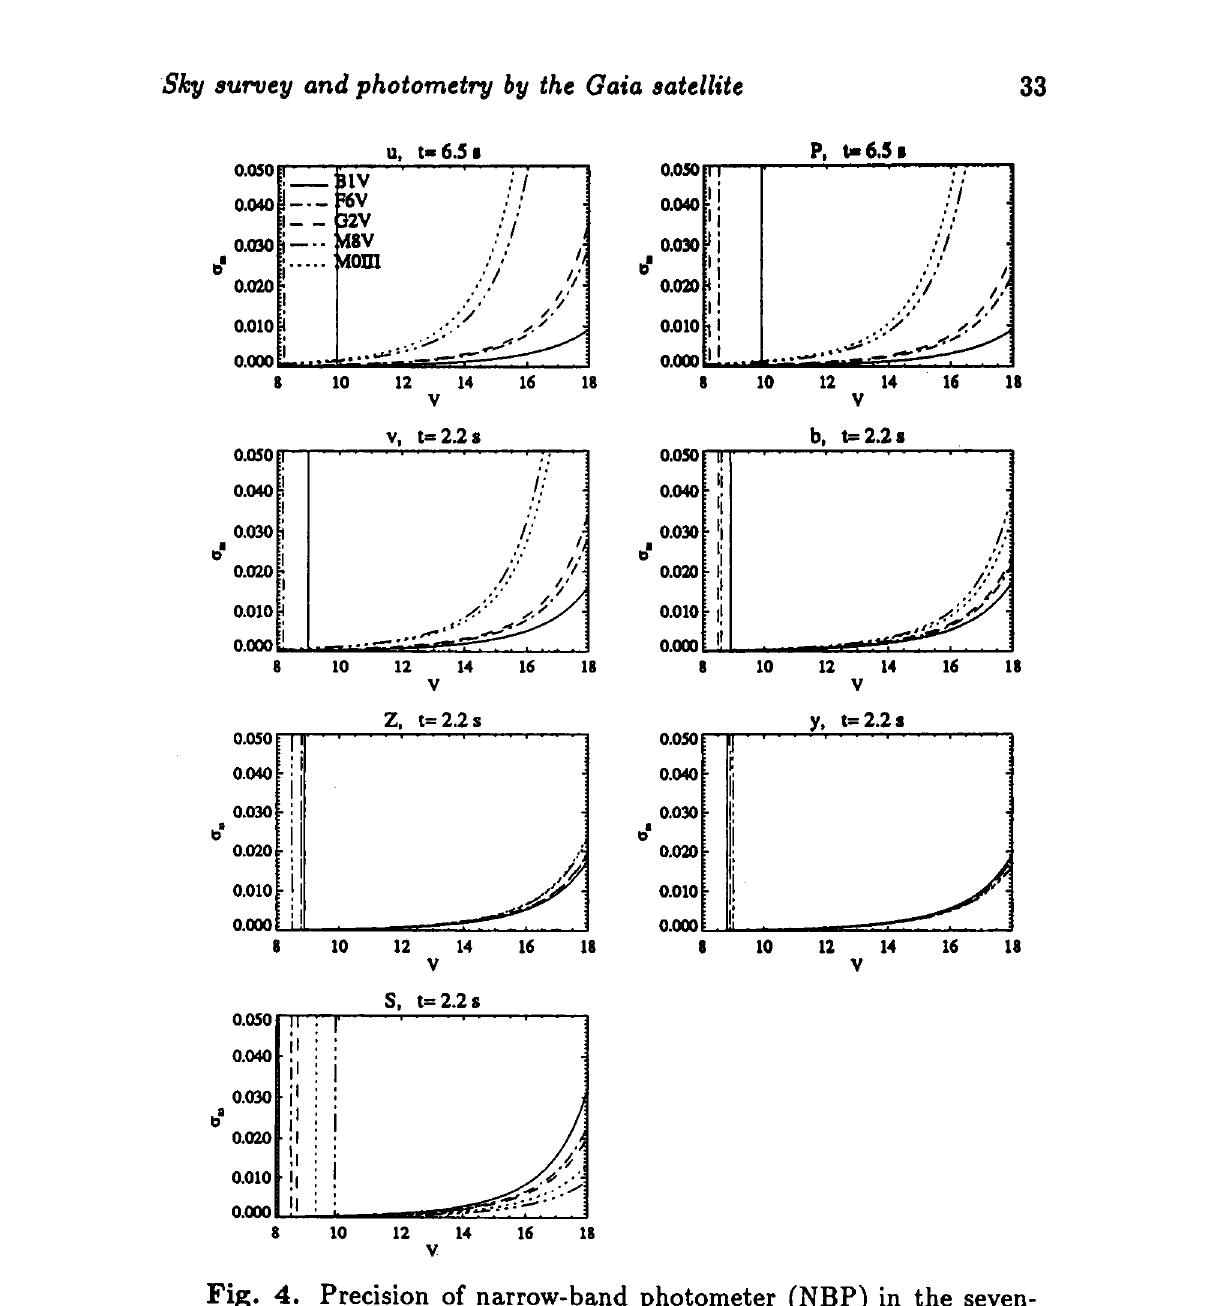
Fig. 4. Precision of narrow-band photometer (NBP) in the seven- color Strömvil photometric system. Average of 100 observations, integra- tion time t, the vertical lines indicate saturation of the CCD at bright stars. Saturation is assumed at 500 000 e- in the serial